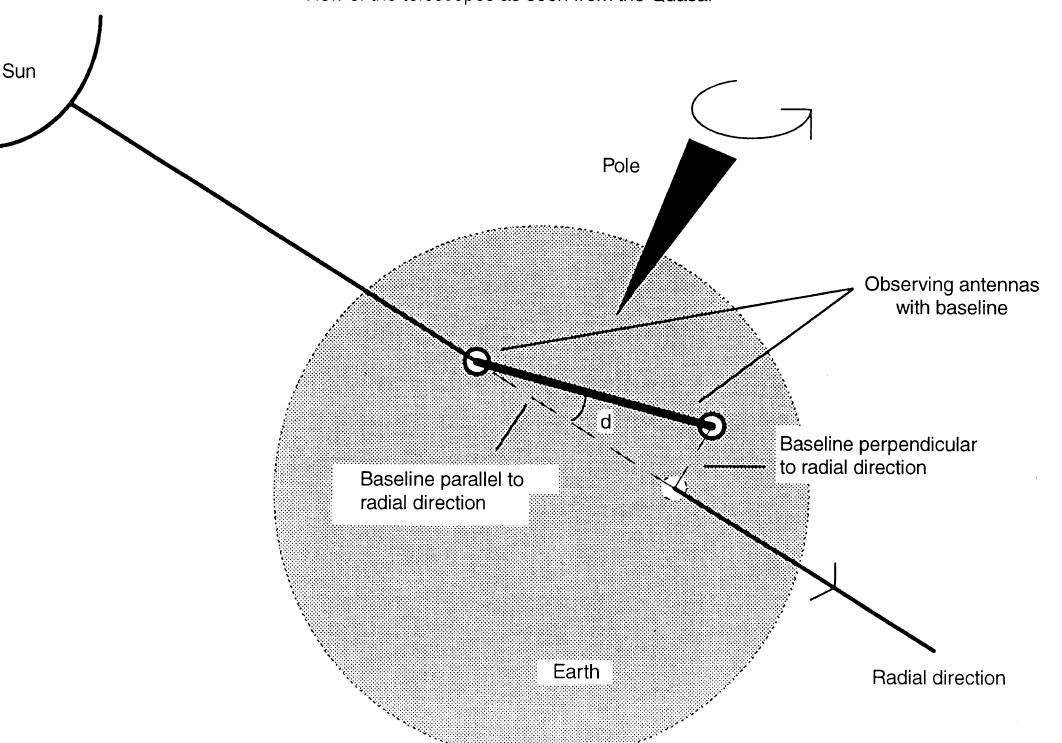
Fig. 1. The orientation of the baseline between the two antennas in relation to the radial plane through the centre of the Sun, which varies as the Earth rotates about its axis